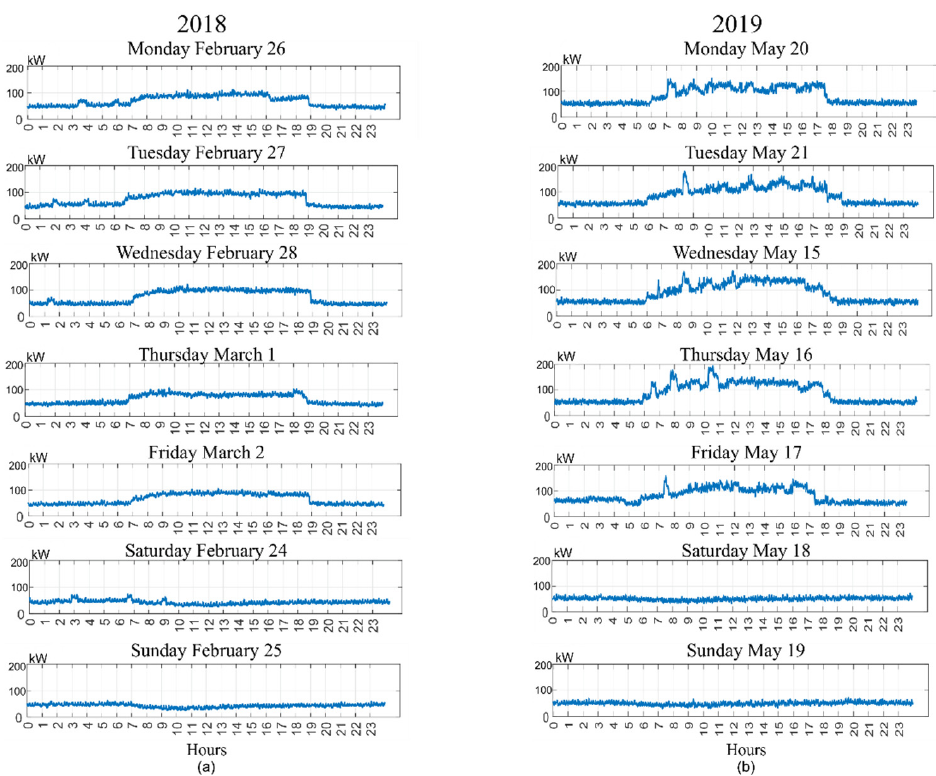
Figure 10. Active Power ( a ) week from 2018 ( b ) week from 2019.